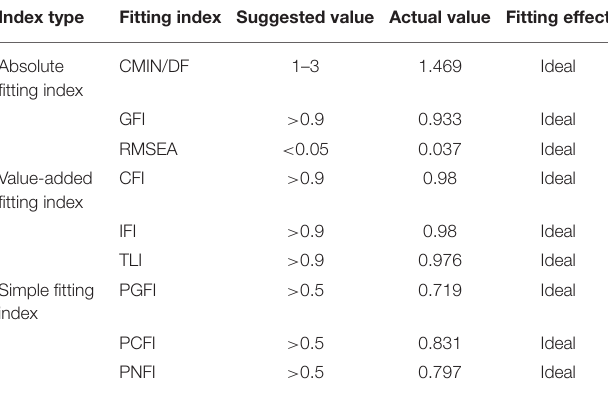
TABLE 5 | Goodness-of-fit of the structural